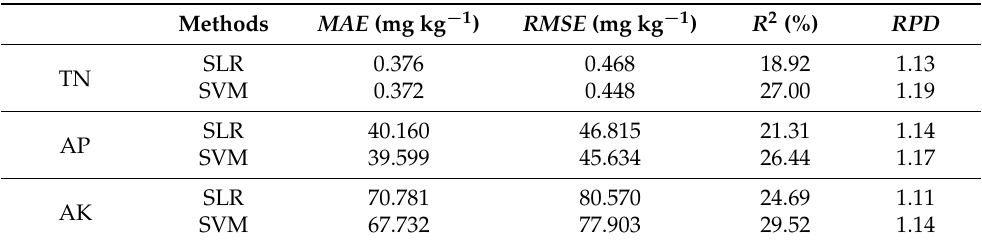
Table 3. The prediction results of soil nutrients using Stepwise Linear Regression (SLR) and Support Vector Machine (SVM) models.